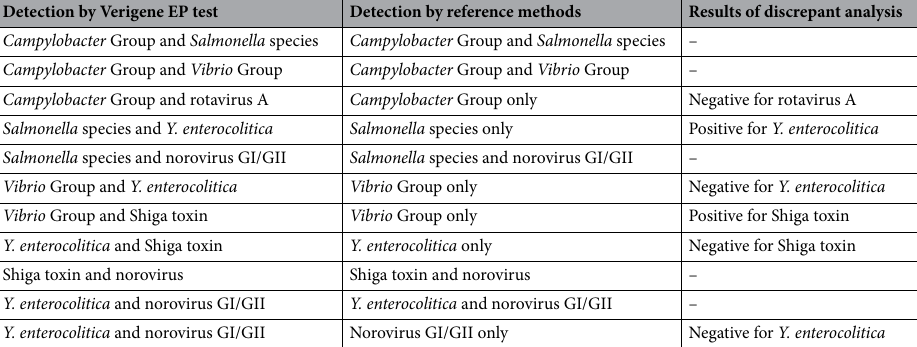
Detection by Verigene EP test